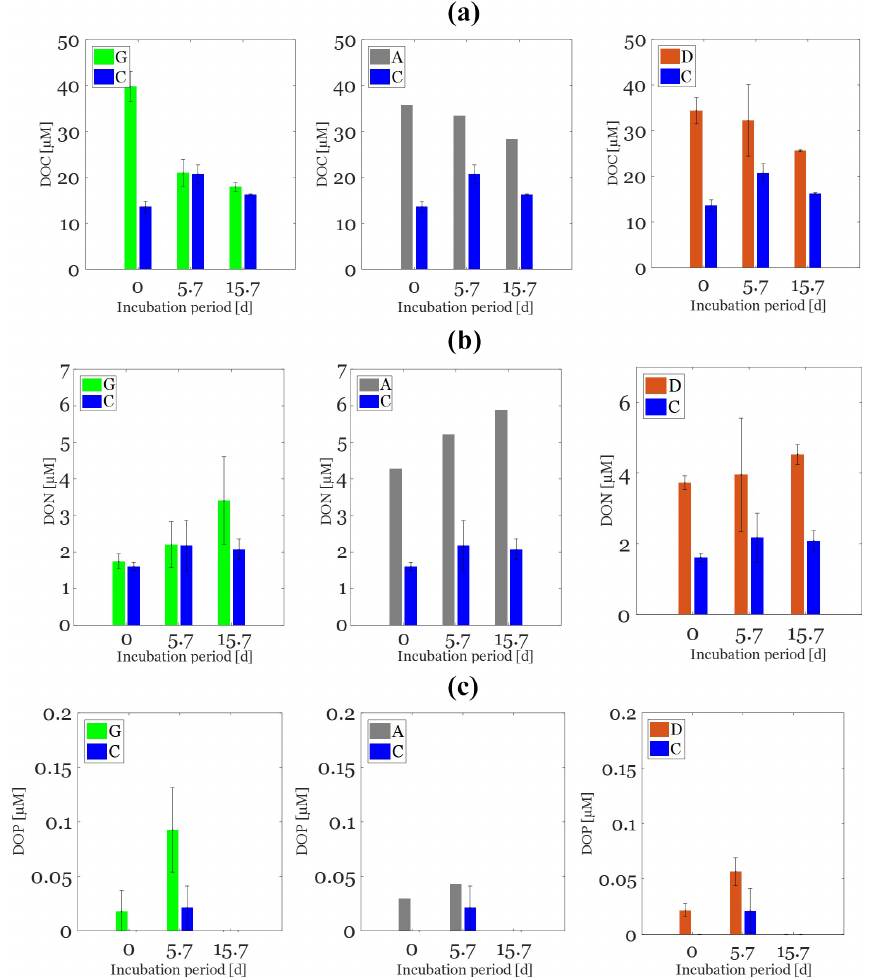
Figure 2. Changes in dissolved organic carbon (DOC, a ), nitrogen (DON, b ), and phosphate (DOP, c ) concentrations over the incubation period in glucose (left, green bars), anthropogenic aerosols (middle, gray bars), and Saharan dust aerosols (right, orange bars). The control is plotted in each panel (blue